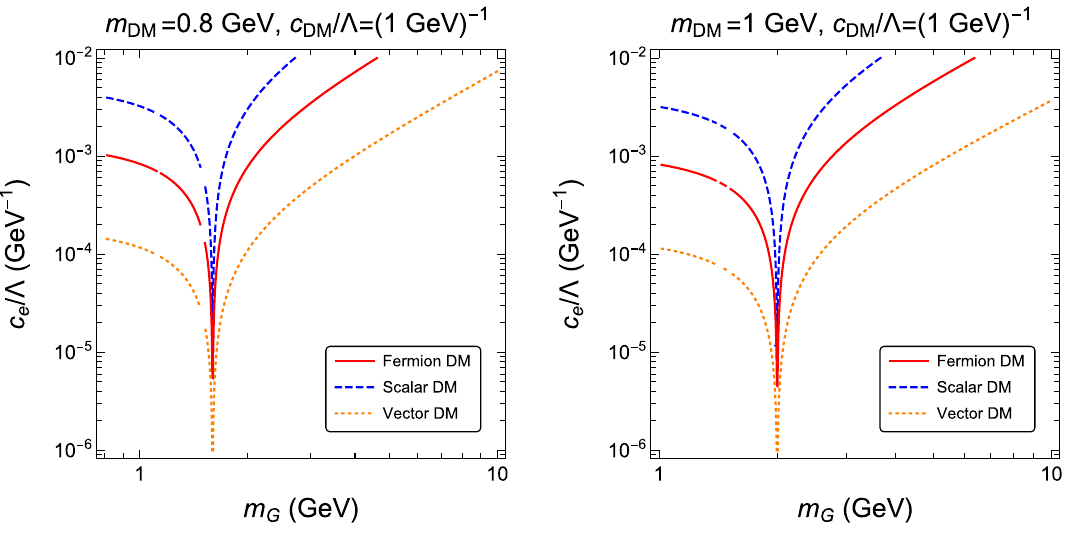
Fig. 3 Parameter space for c e /(cid:3) vs m G for light dark matter with m DM < m G . The correct relic density is satisfied in red solid, blue dashed and orange dotted lines for fermion, scalar and vector dark mat-